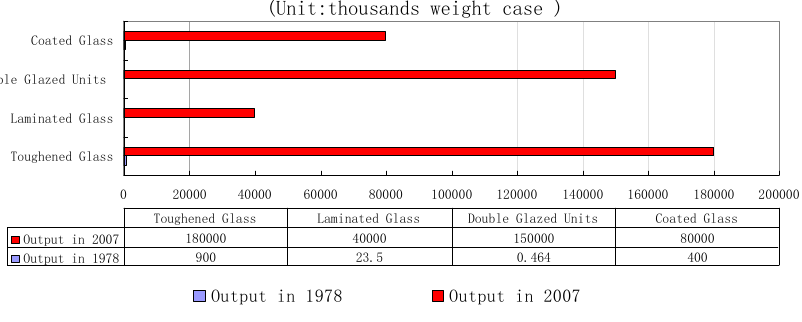
Figure 2: The compared diagram of glass factories in 1978 and